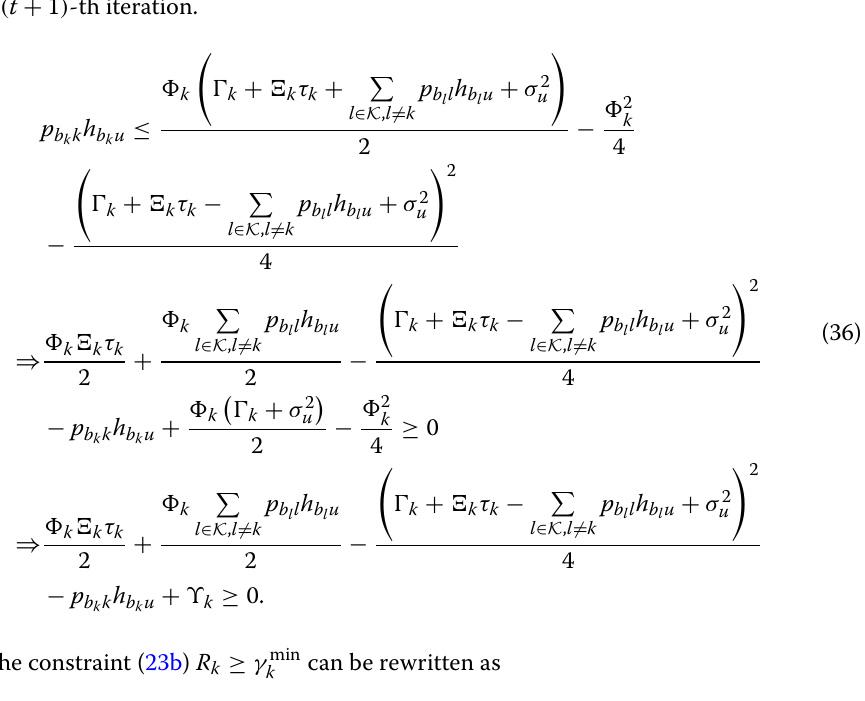
According to (35), inequality (24c) can be derived as a further tight constraint (36) at the ( t + 1 ) -th